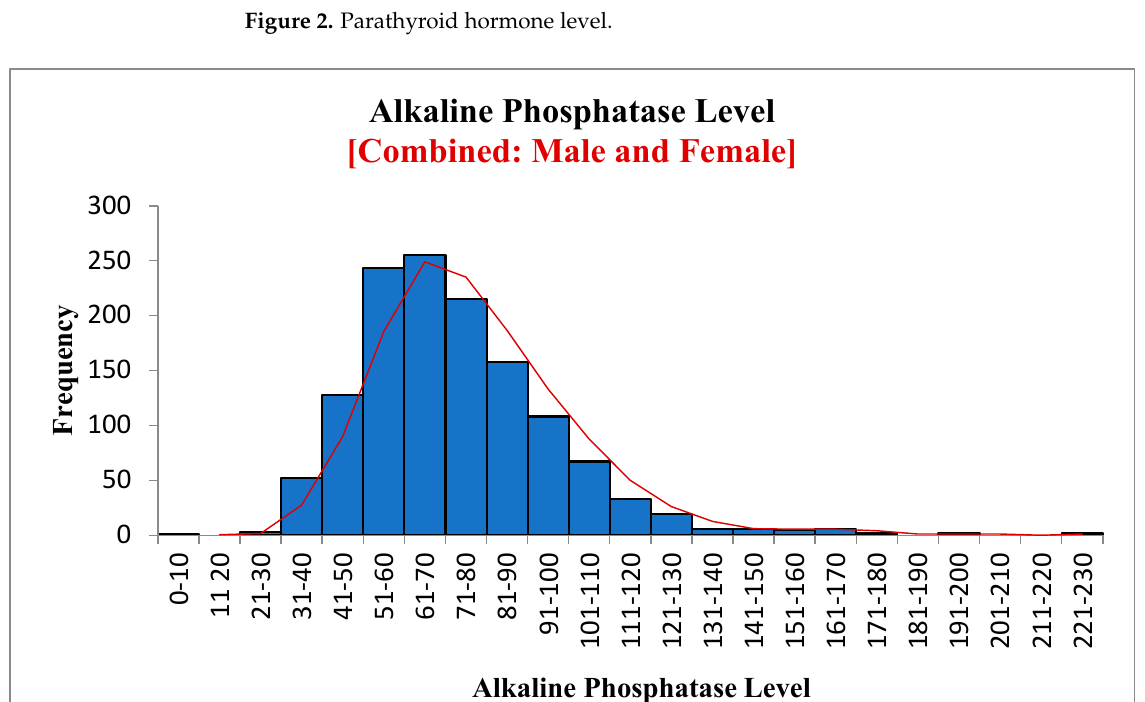
Figure 3. Alkaline phosphatase level. Figure 3.